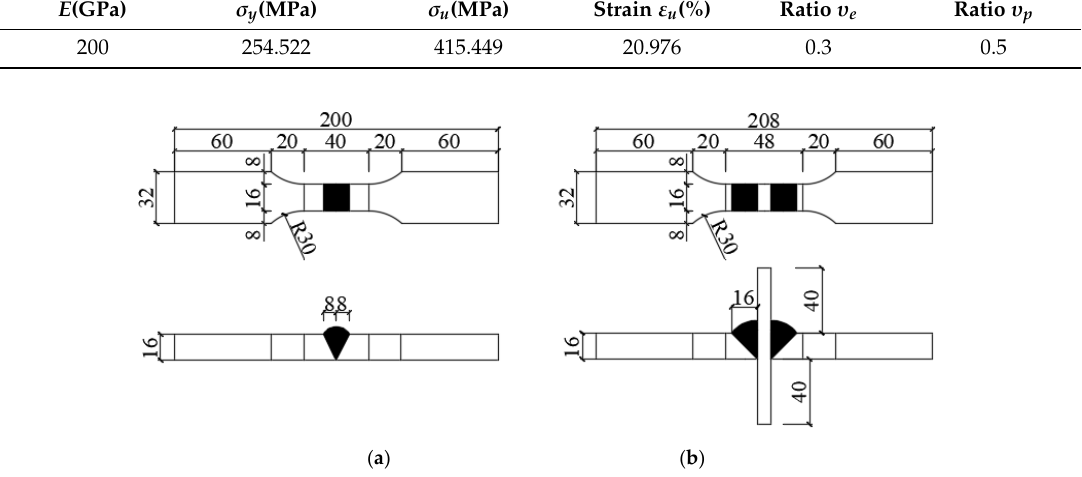
Figure 1. Design of welded specimens (mm): ( a ) plate butt (PB); ( b ) cruciform load-carrying groove (CLG).